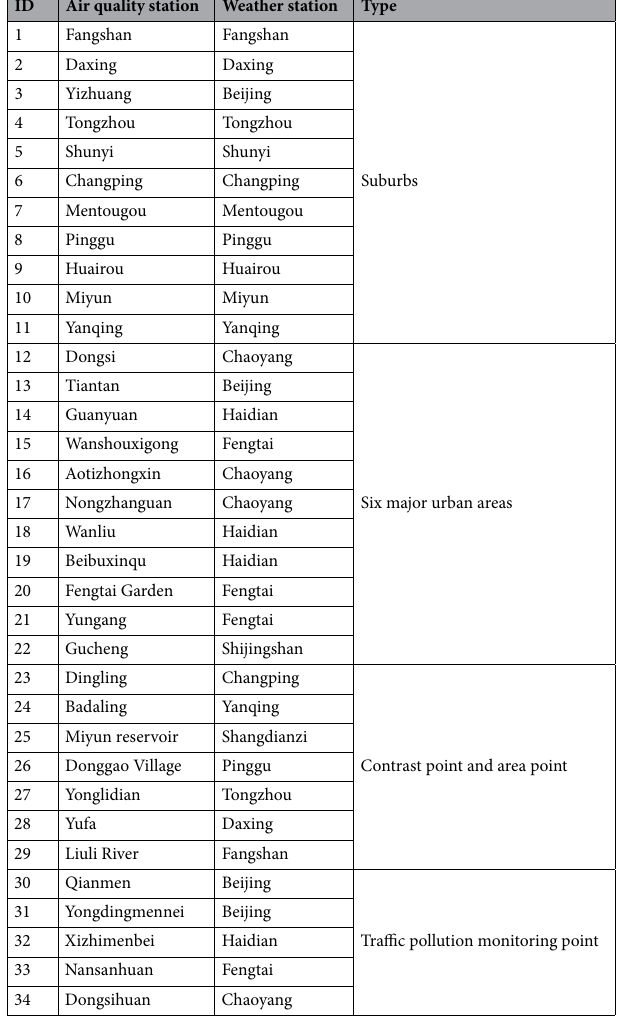
Table 6. Matching results of the weather station and air quality